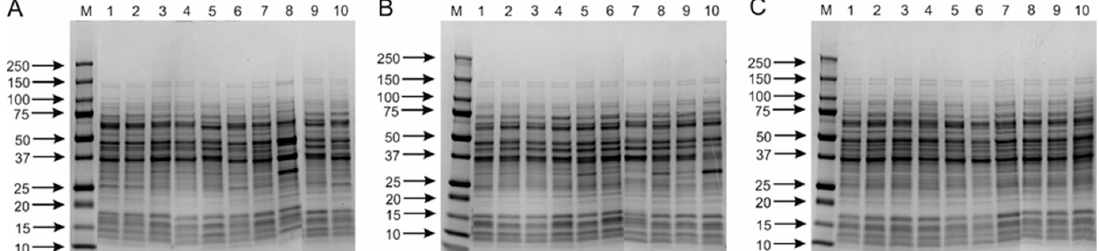
Figure 5. SDS-PAGE profiles of whole cell proteins obtained for all tested lactobacilli belong to L. casei group. Analysis of the discriminatory power of this technique was performed for 10 strains of L.